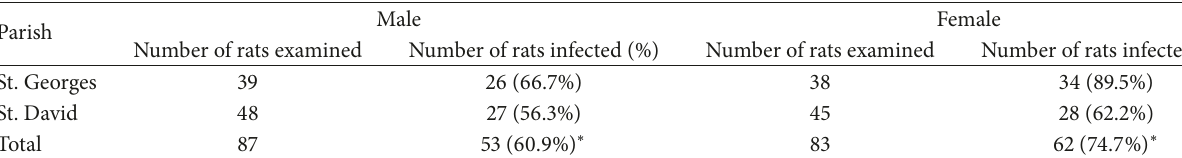
Table 2: Prevalence of Cysticercus fasciolaris in brown rats of Grenada according to gender.